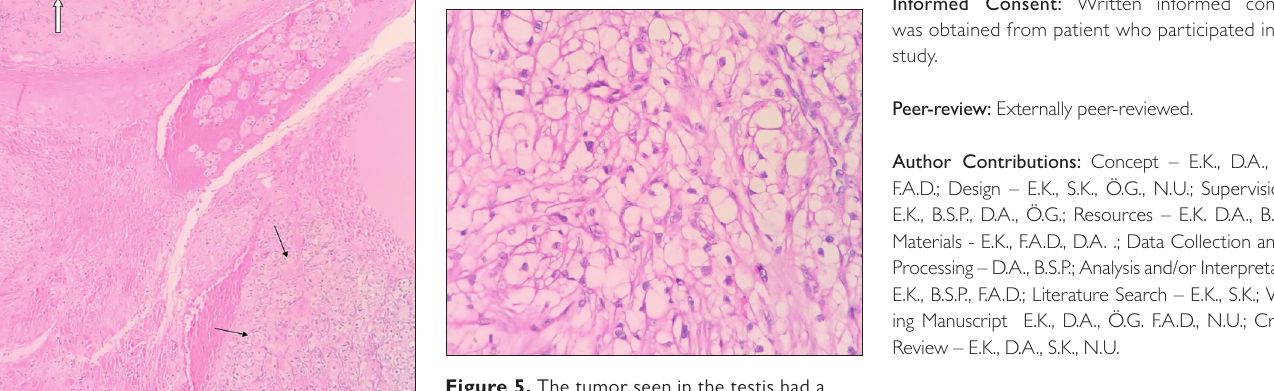
Figure 5. The tumor seen in the testis had a similar appearance to that detected in the kidney; tumor cells with variable small irregular nuclei and large pale cytoplasm organized in nests and trabecules (Magnification